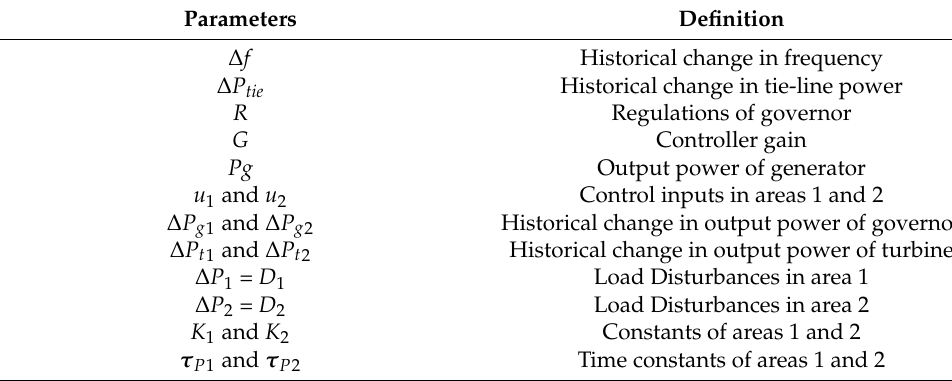
Table 1. Nomenclatures of the two-area power